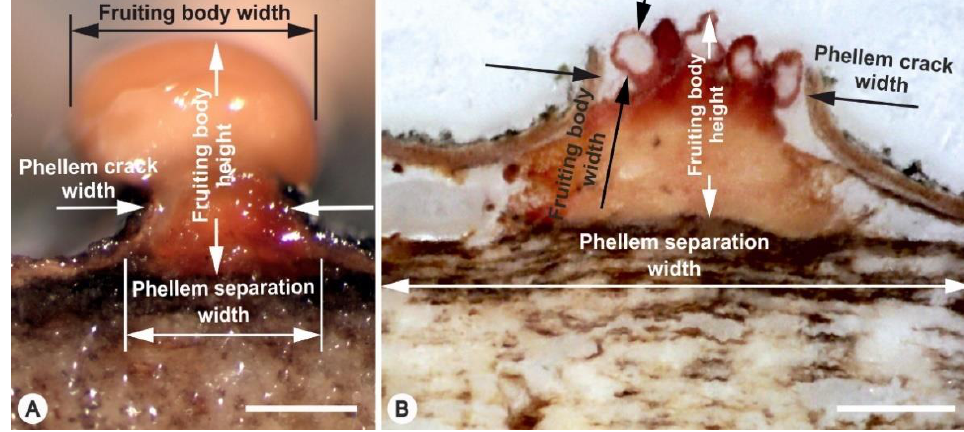
Figure 2. The scheme of fruiting body size measurements in the anamorph ( A ) and teleomorph ( B ) stages, respectively. Cross-sections, scale bars = 500 µm.